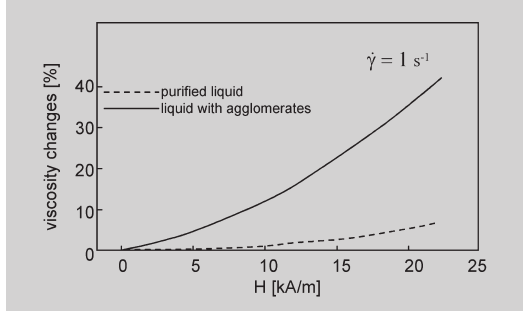
Figure 7: Relative change of viscosity for two fluids with identical magnetic concentration and different amount of primary